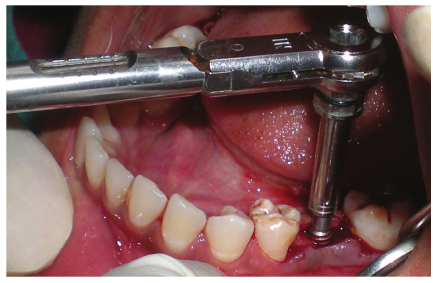
Figure 8: Radiographic view of the implant after